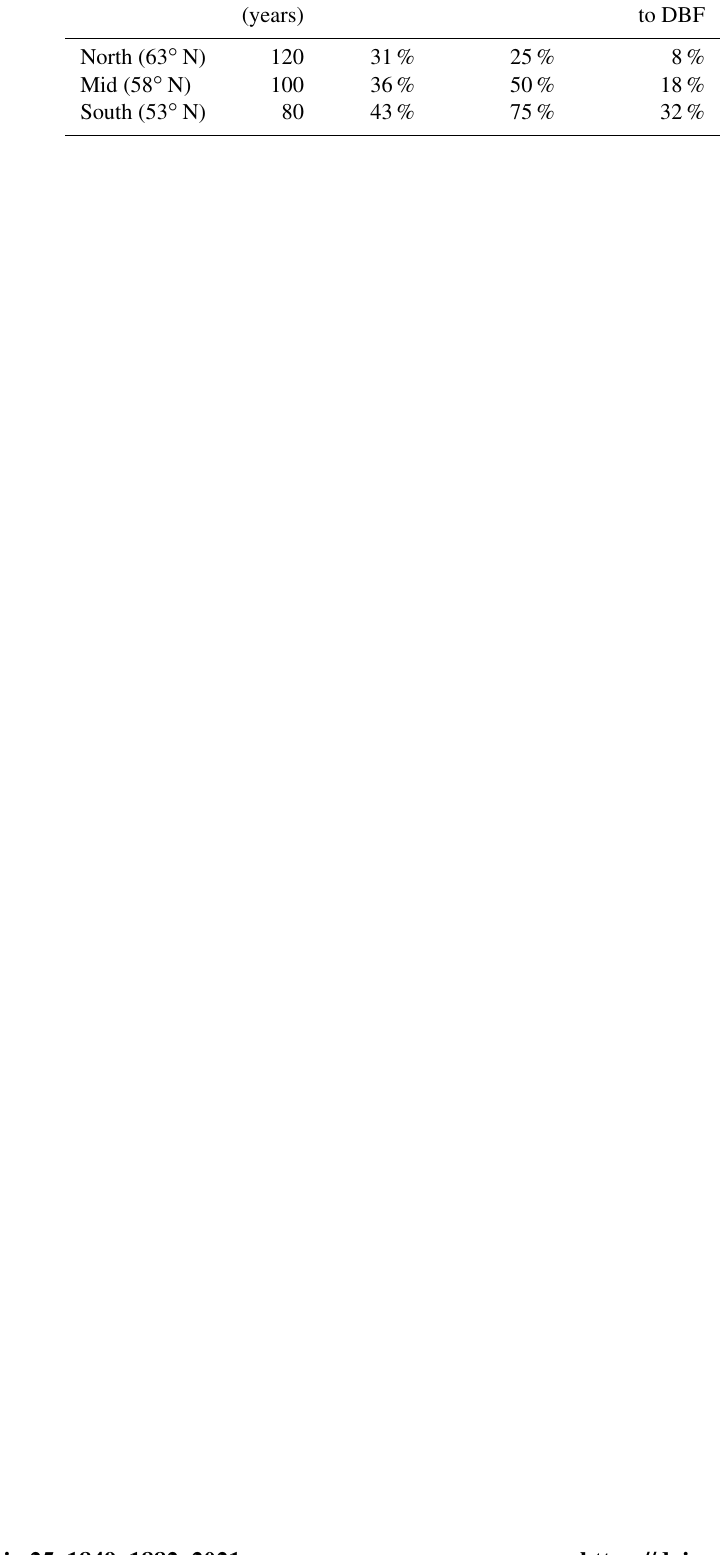
Table A2. CCRN expert-guided north–south gradients in the post-fire conversion of ENF to DBF in the contiguous Boreal and Taiga Forest. Location Fire ENF fraction Conversion Fraction